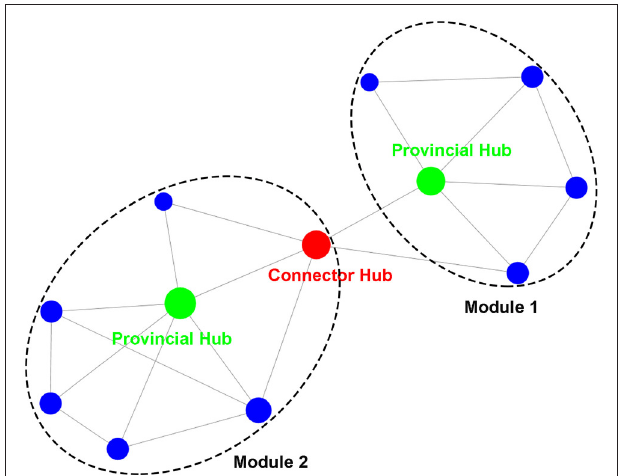
FIGURE 1 | Illustrations of modules and hubs in a network. The modules with dense intra-community connections are identified within the dashed circles. The hubs are the nodes with high degrees (the number of connections that are maintained by a node) that are reflected by the size of nodes. Provincial hubs primarily connect nodes of their own module, while connector hubs are important in bridging different